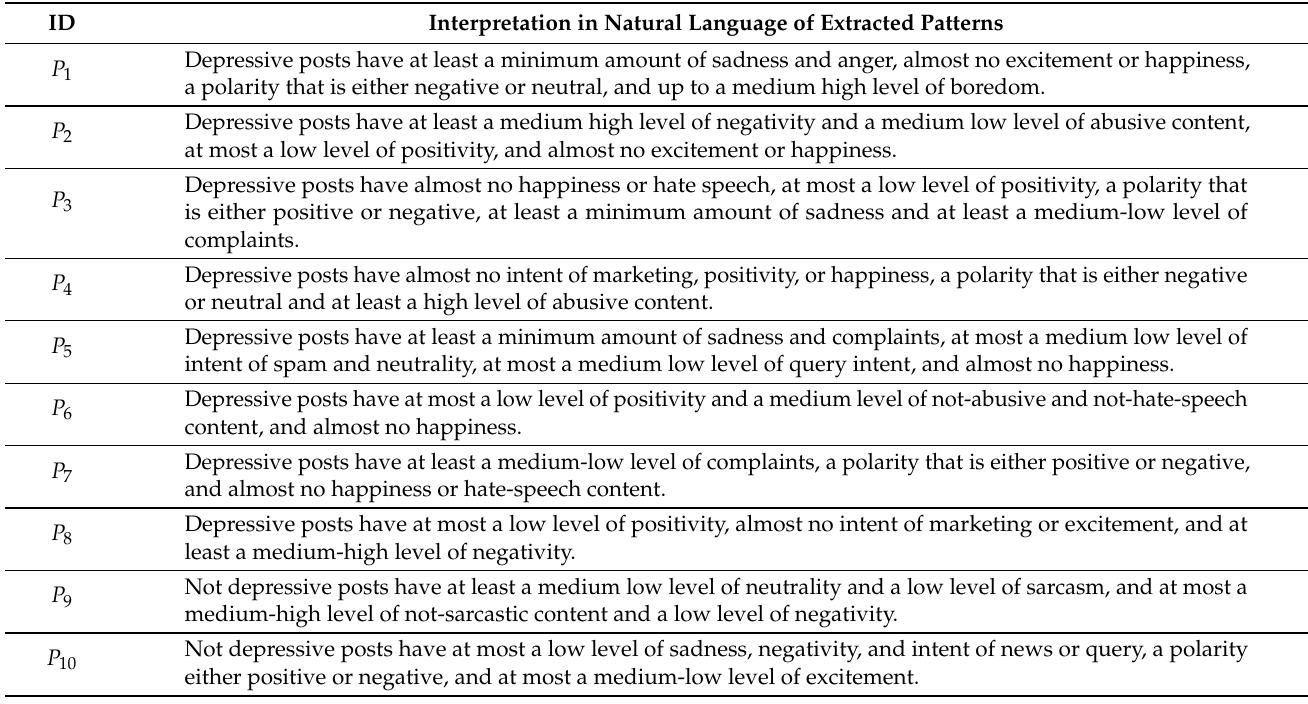
Table 10. Explanation in natural language of example patterns in Table